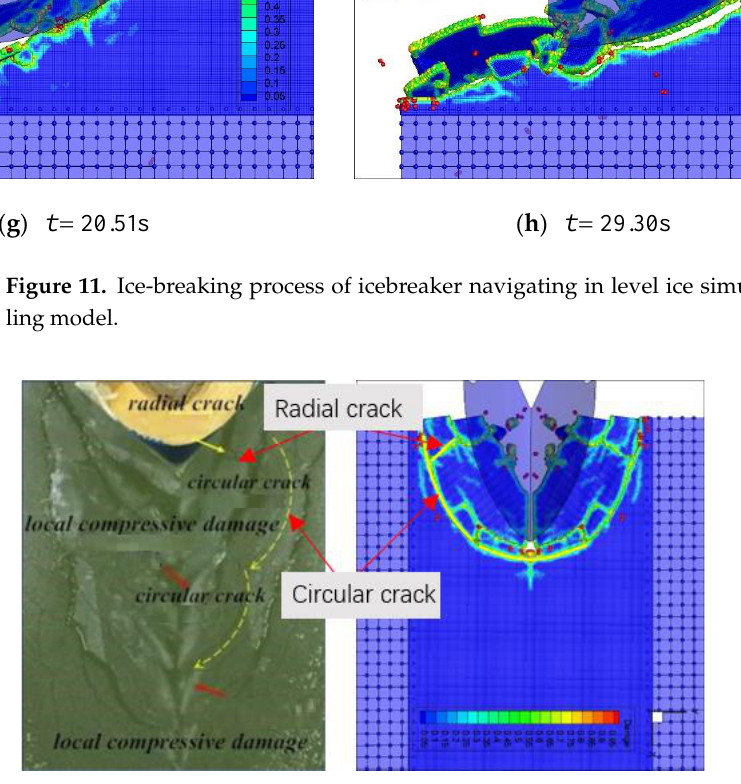
Figure 11. Ice-breaking process of icebreaker navigating in level ice simulated by PD-FEM coupling model.